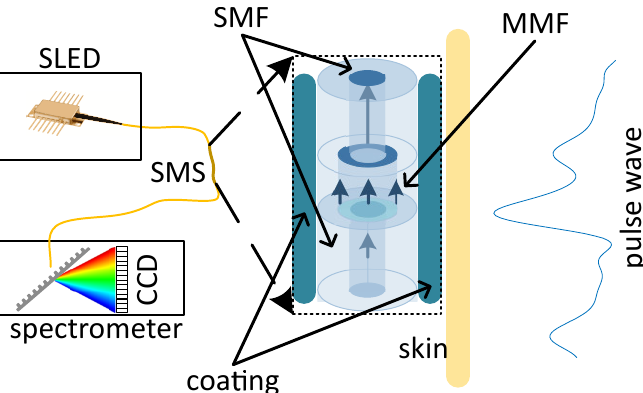
Figure 5. Schematic illustration of sensing setups for SMS pulse wave